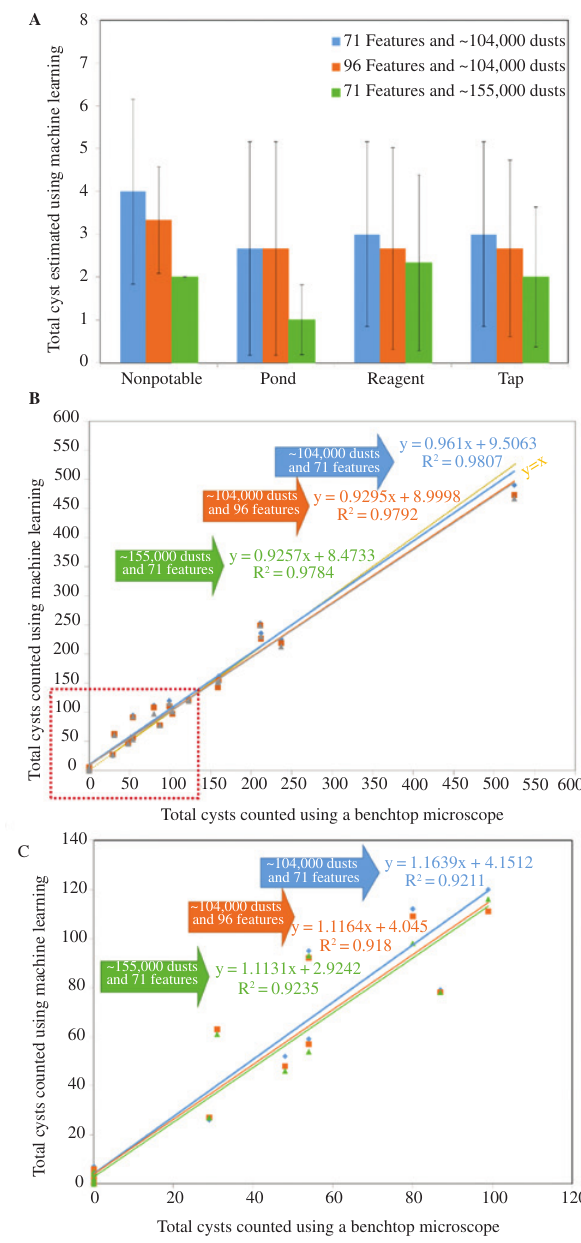
Figure 5: Predicted cyst levels corresponding to 10 ml of (A) Giardia - free samples from various water sources, (B) Giardia -free and Giardia -spiked water samples, (C) low concentrations of Giardia - spiked samples using different training databases for a bagged tree classifier with 400